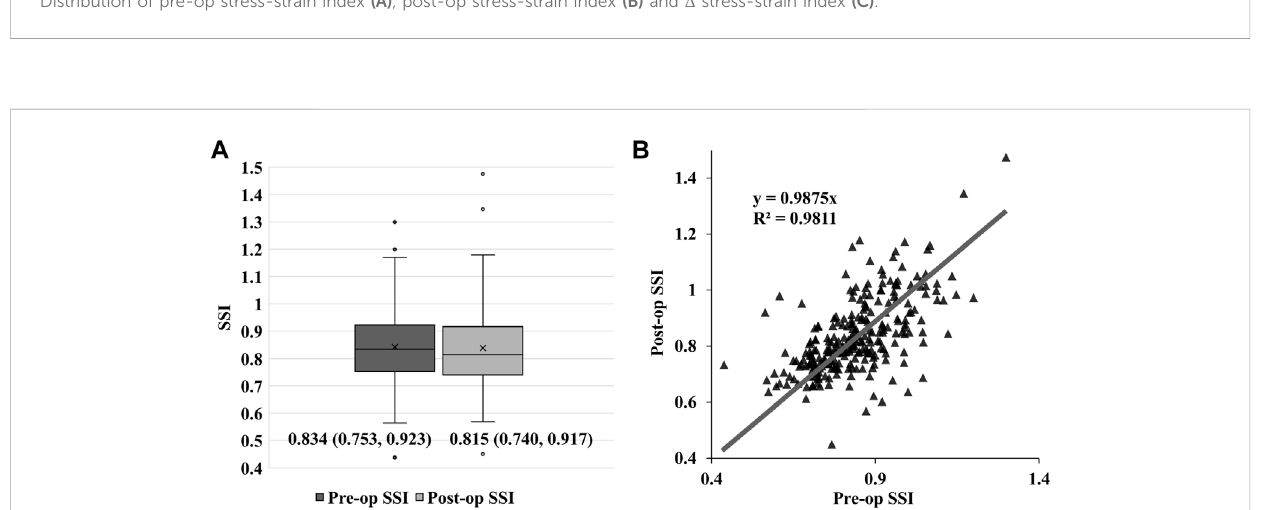
FIGURE 2 Box-plot graph of the pre-and post-op stress-strain index (SSI) values. The bar inside each box represents the median, and each box extends from the 25th percentile to the 75th percentile distribution in each group. The median of the post-op SSI values is lower than the pre-op SSI values without statisticaldifference( p > 0.05),andthetwogroupshaveacomparabledataspread (A) .Scatterdiagramandlinear fi tforpre-andpost-opSSIvalues,post- op SSI = 0.988×Pre-op SSI, R 2 = 0.981 (B)